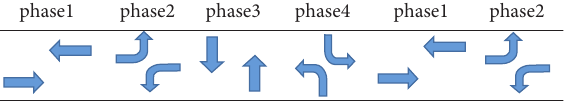
Figure 7: Recognized traffic phases.